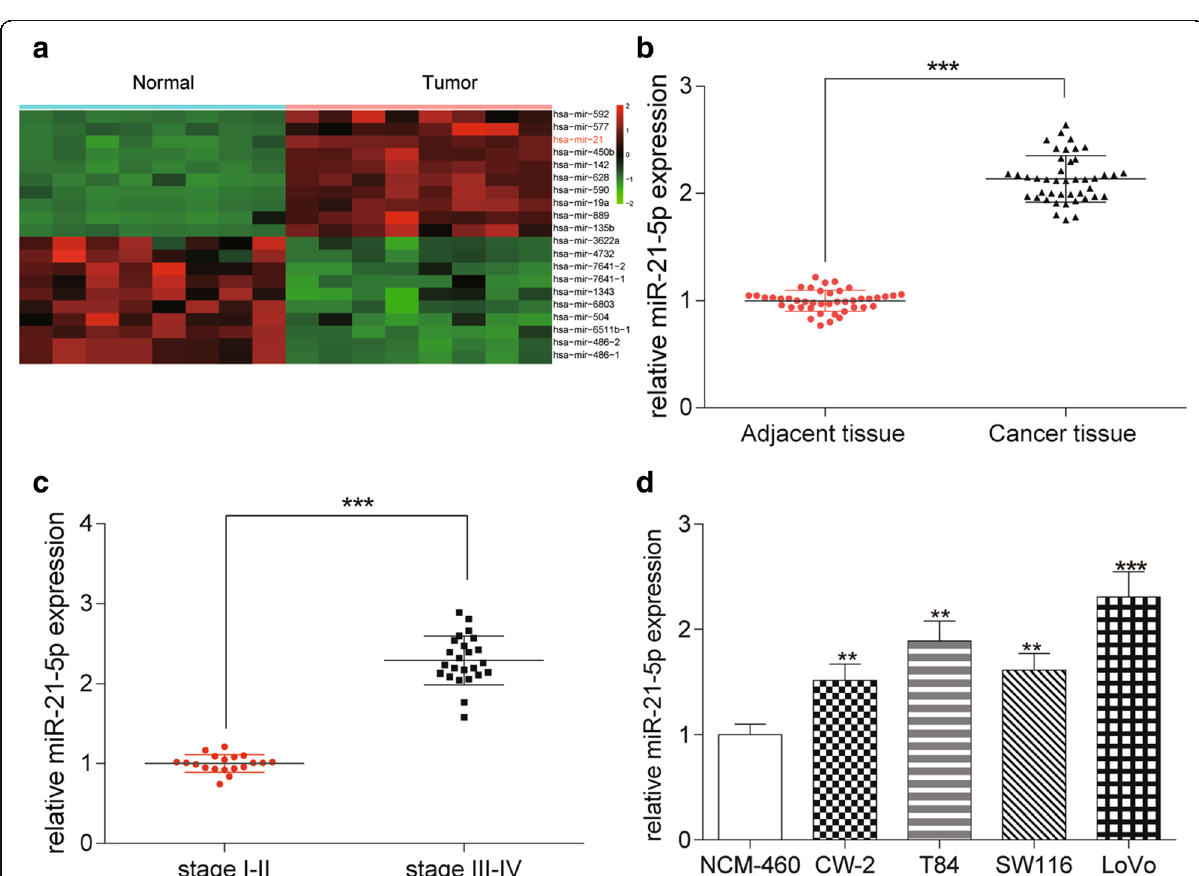
Fig. 1 MiR-21-5p highly expressed in COAD tissues and cells. a The heat map showed that miR-21-5p was high expressed in COAD tissues compared with normal tissues. b The relative expression of miR-21-5p in cancer tissues was much higher than that in adjacent tissues detected by qRT-PCR. *** P < 0.001, compared with adjacent tissue. c The expression of miR-21-5p in stage III-IV was notably higher than that in stage I-II detected by qRT-PCR. *** P < 0.001, compared with stage I-II. d The expression of miR-21-5p in COAD cell lines (CW-2, T84, SW116, LoVo) was higher than that in normal colonic epithelial cell line (NCM-460) detected by qRT-PCR, which reached the highest level in LoVo cell line. ** P < 0.01, *** P < 0.001, compared with